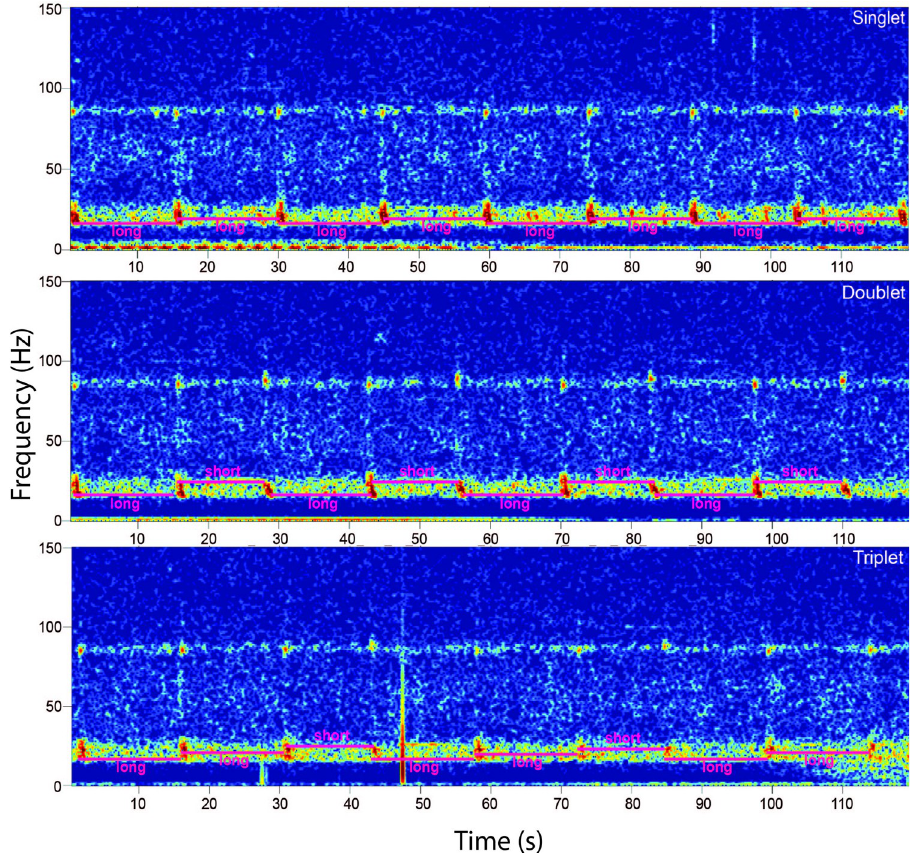
Fig 2. WAP fin whale song. Two-minute spectrograms recorded in the vicinity of South Shetland Island on April 2, 2015, depicting patterned fin whale 20 Hz pulses with accompanying overtones. The spectrograms display all three recorded song variants: singlet (top), doublet (middle), and triplet (bottom). The spectrograms were calculated using 2000-point FFT, 90% overlap and Hanning